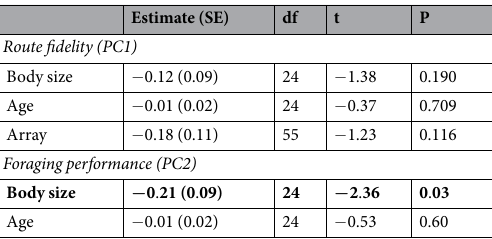
Estimate (SE) df P